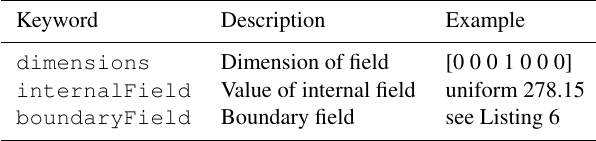
Table 2. Main keywords used in field dictionary